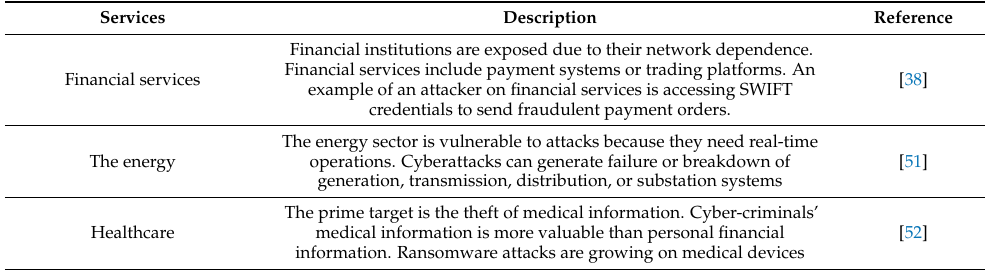
Table 6. Classification of cybersecurity attacks based on target services.